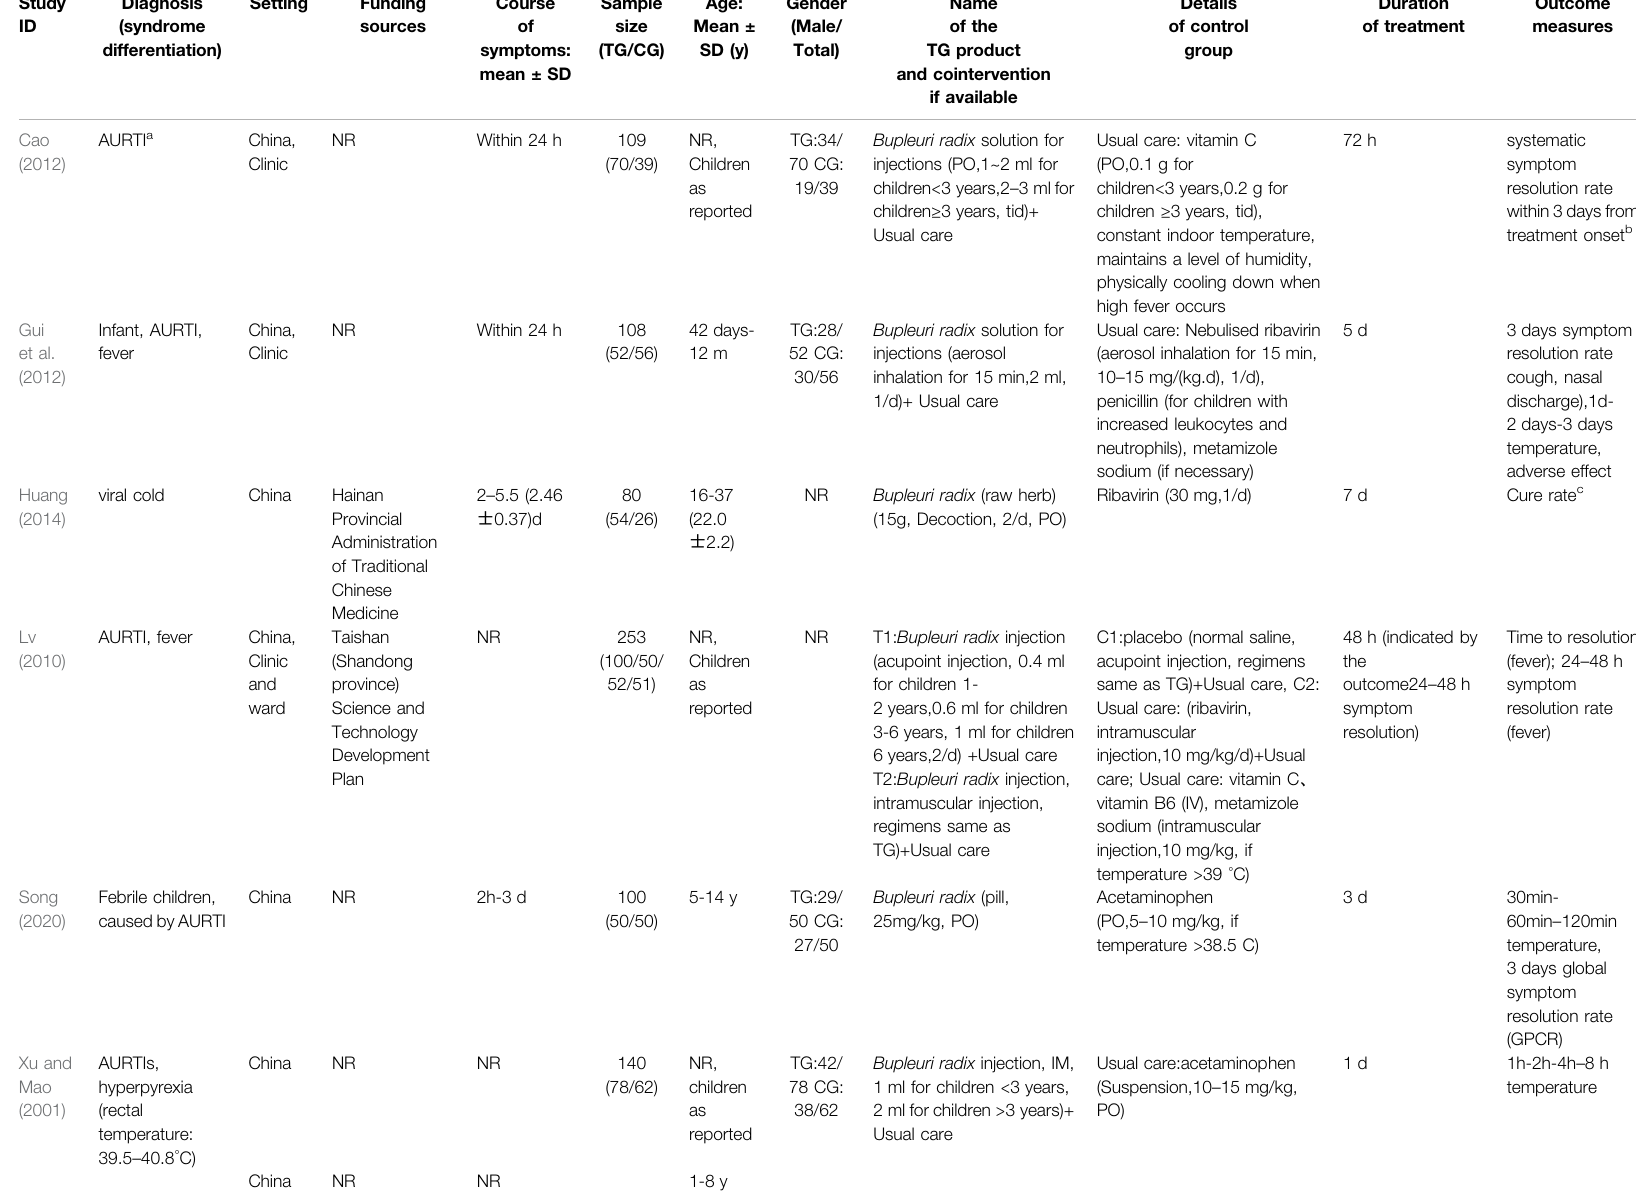
TABLE 1 | Characteristics of included